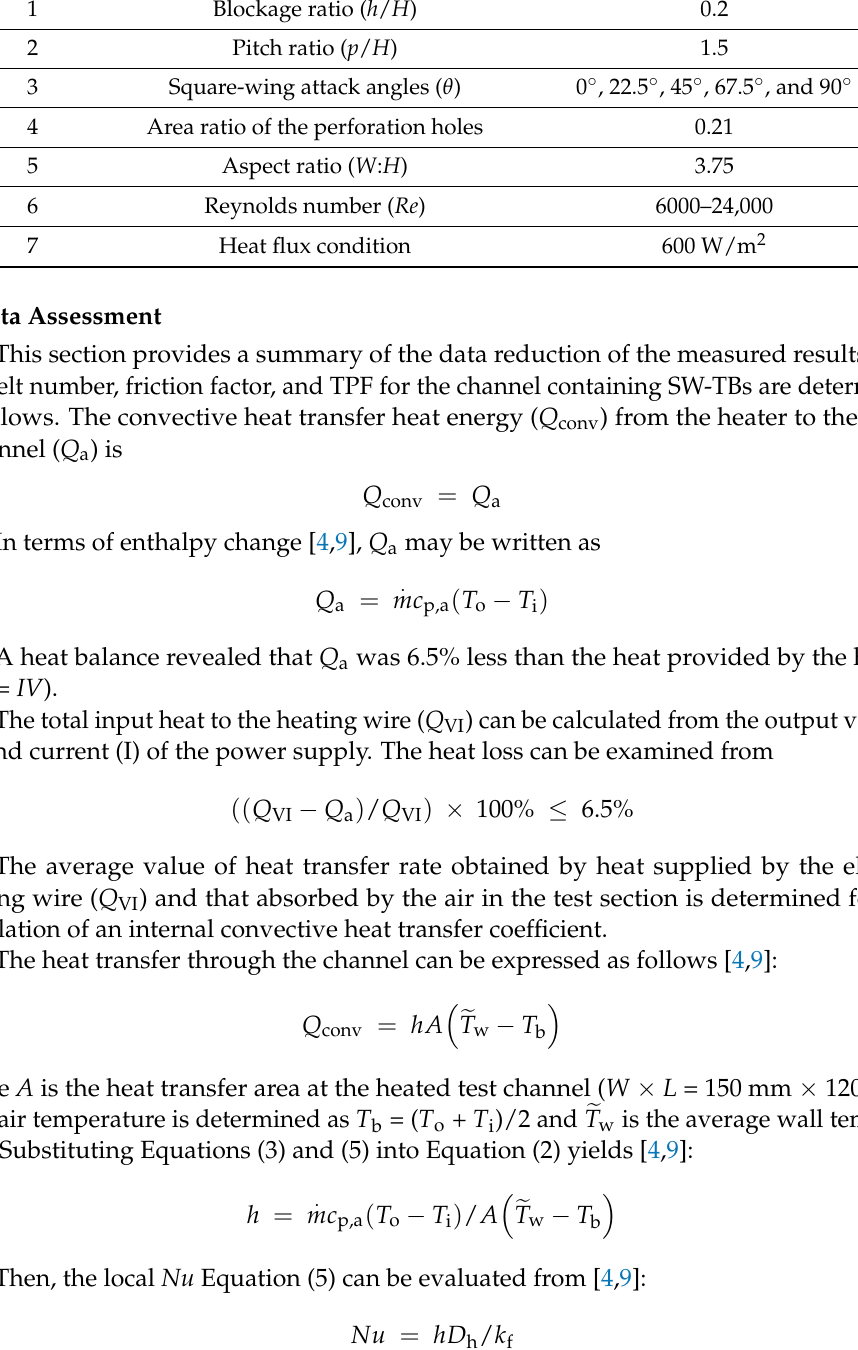
Table 1. The geometric parameters and conditions of the experiments.